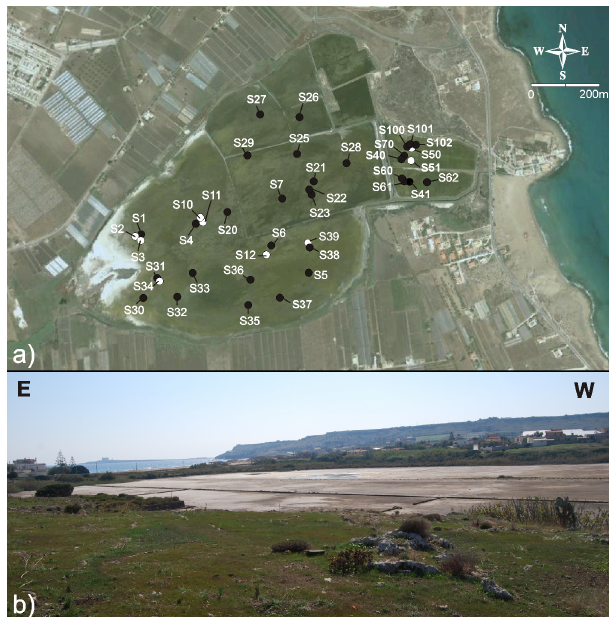
Fig. 2. (a) Satellite imagery of the study area; core locations are shown by white dots (engine cores) and black dots (hand cores); (b) photograph of the site (courtesy of Paolo Marco De